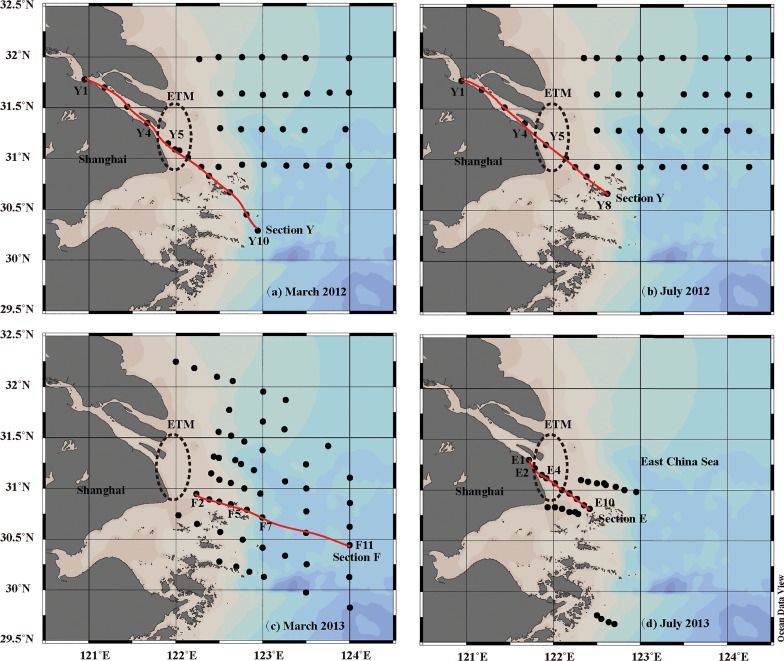
Map of sampling stations in four different cruises.(a) March 2012; (b) July 2012; (c) March 2013; (d) July 2013. Four axial sections of the Yangtze Estuary are connected and marked by red lines. ETM regions are marked by dashed eclipses. Black dots indicate the sampling sites.